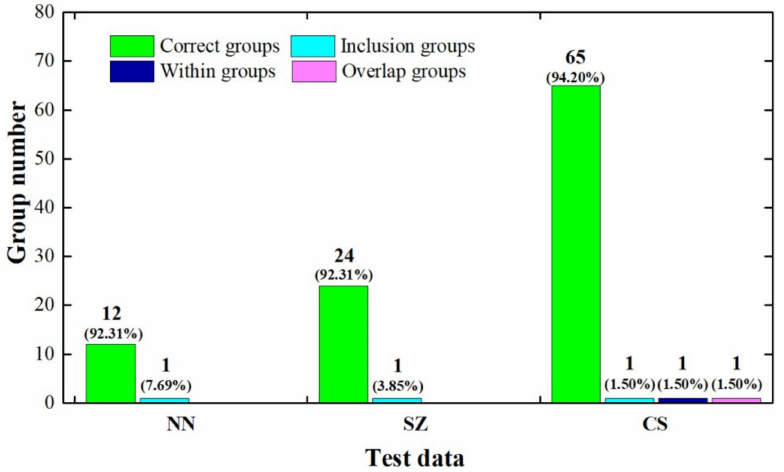
Figure 10. The distributions of recognized linear building patterns in the three